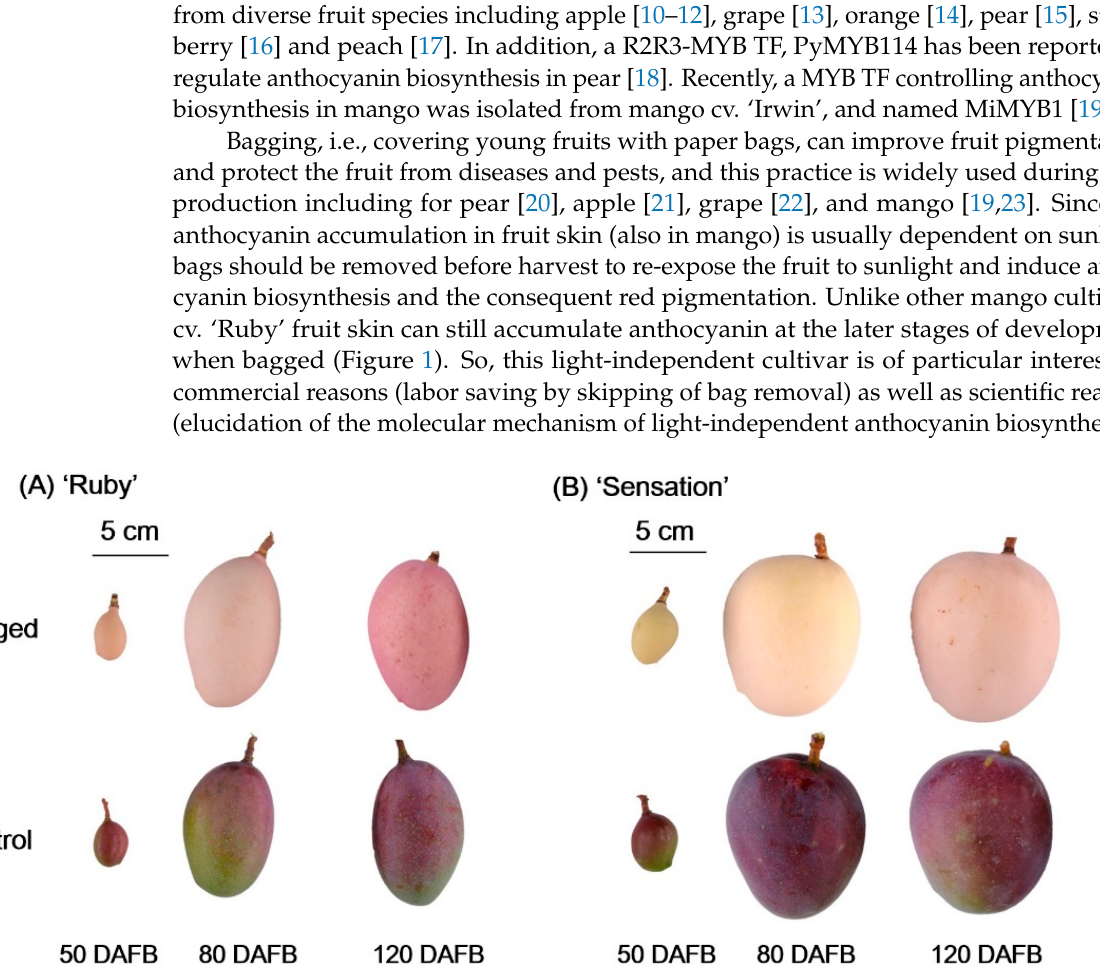
Figure 1. Representative images of bagged and control (un-bagged) ‘Ruby’ ( A ) and ‘Sensation’ ( B ) mango fruits during different developmental stages (DAFB is Days after full bloom).